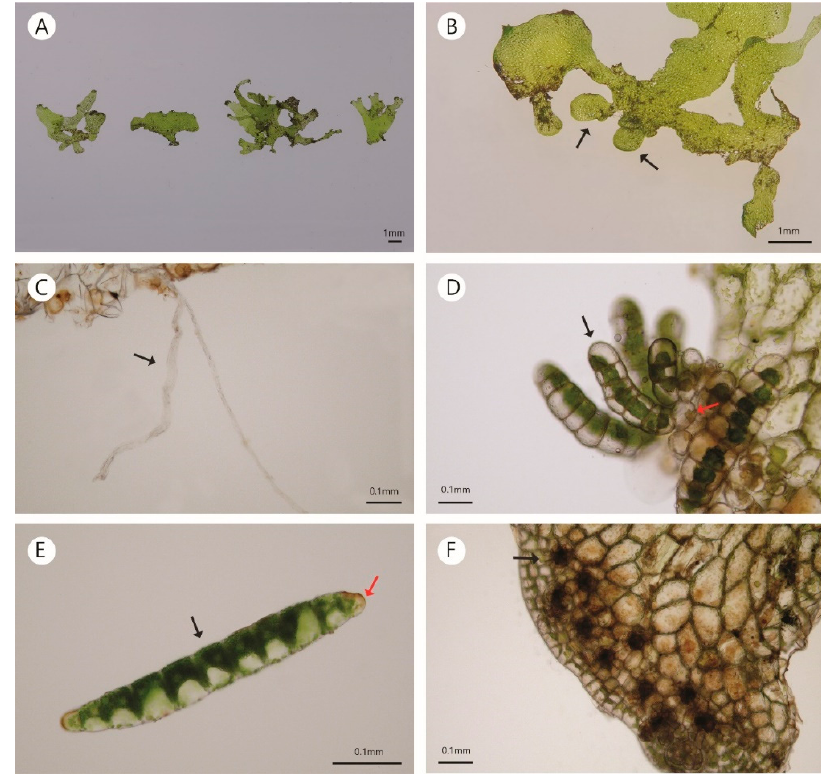
Figure 2. Morphology of the gametophytes of Antrophyum obovatum . ( A ) Various forms of the thallus. ( B ) Irregular branching (black arrow). ( C ) Rhizoid. ( D ) Gemma (black arrow) and gemmifer (red arrow) at the end of aerial branches. ( E ) Body cells (black arrow) and rhizoid primordia (red arrow) of the gemma. ( F ) Archegonium (black arrow) at the marginal lobes of horizontal branches. A few juvenile sporophytes grew within the patch of gametophytes at site B (Figure 3A). The leaves were glabrous, obovate, round at the apex, and less than 6 mm in length (Figure 3B). The rhizomes were short and erected. The rhizome scales were dark brown, ovate, lanceolate, and clathrate (Figure 3C). The gametophytes remained in the laboratory for more than two years after collec- tion; however, gemmae did not arise from any individual. The juvenile sporophytes wilted six months after translocation, without any morphological changes.